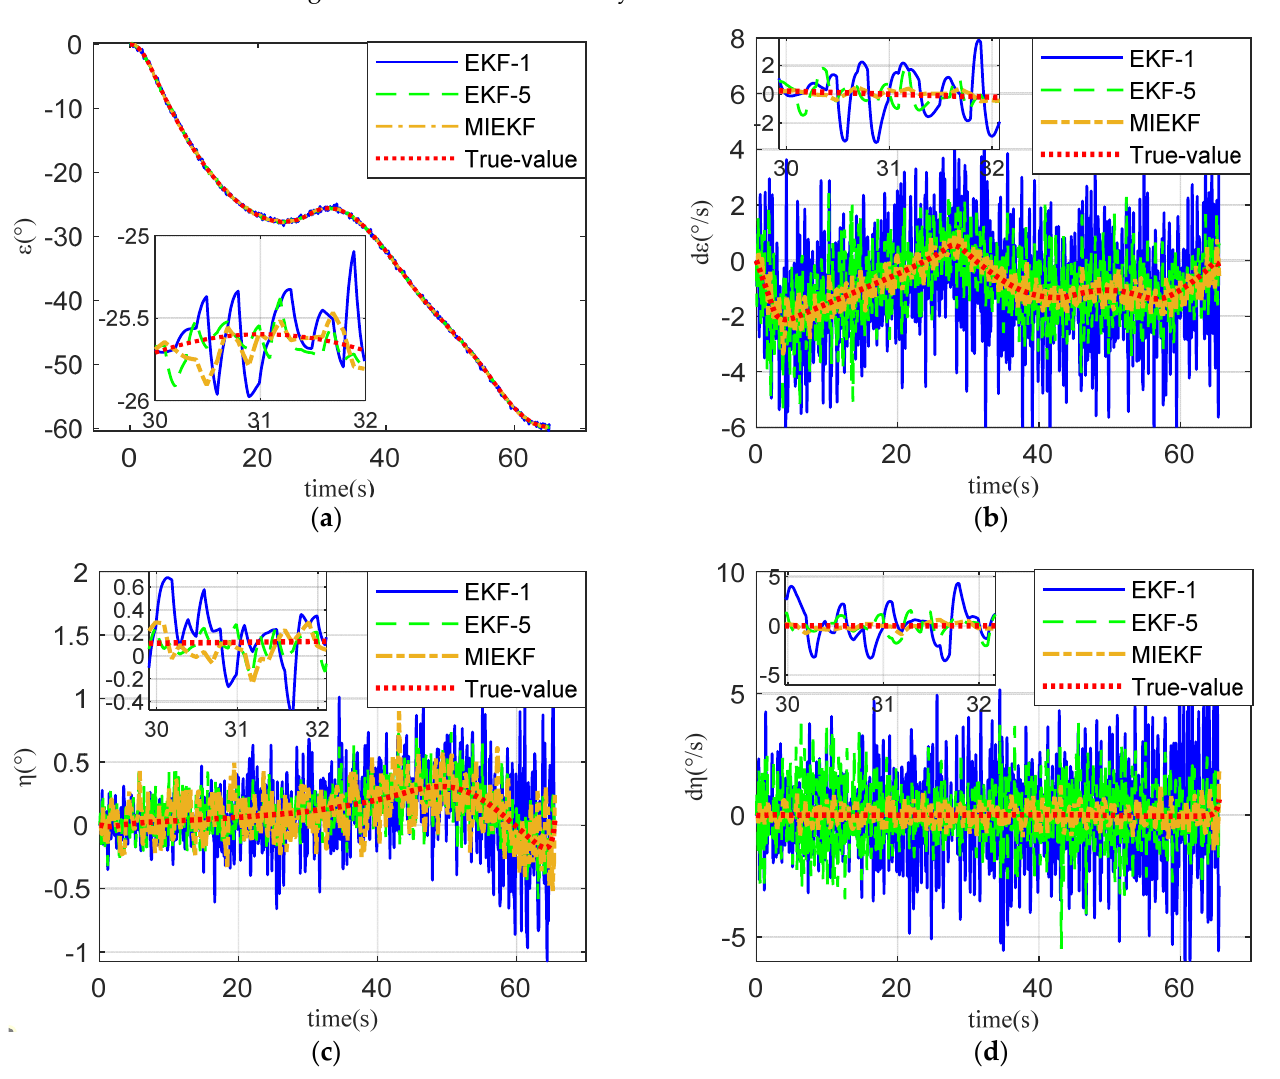
Figure 12. The results of EKF & MIEKF. ( a ) Elevation of line-of-sight. ( b ) The rate of elevation of line-of-sight. ( c ) Azimuth of line-of-sight. ( d ) The rate of azimuth of line-of-sight.